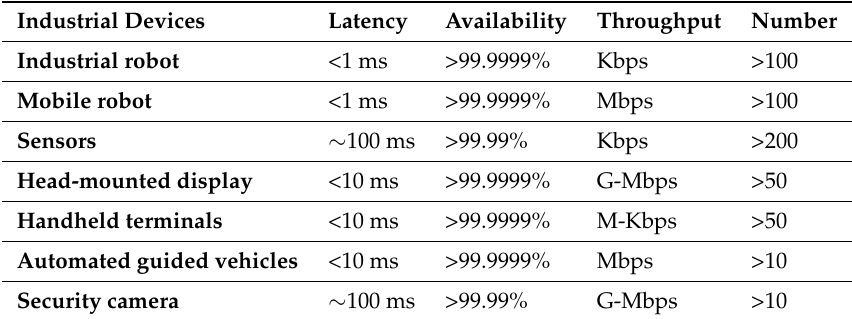
Table 2. Key performance requirement (KPI) of Industry 4.0 devices